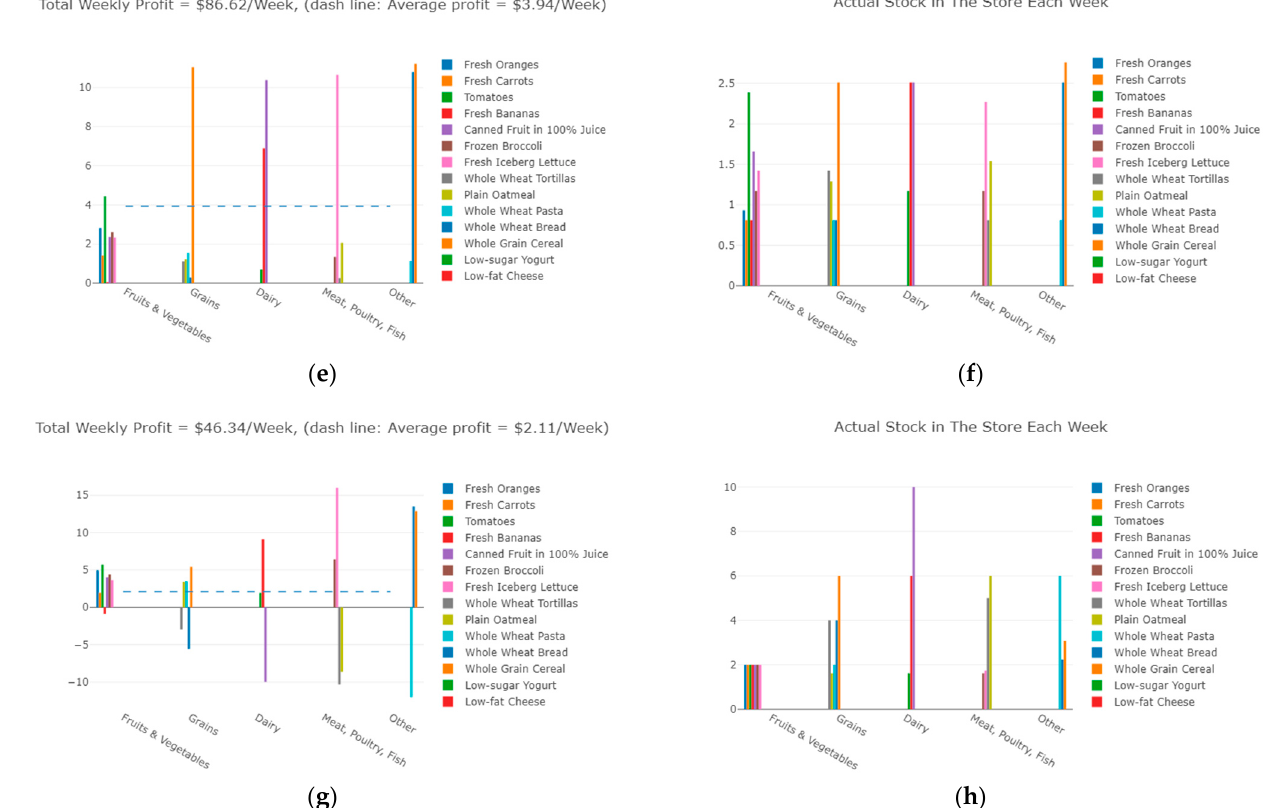
Figure 7. Simulation Results: ( a ) SNAP Minimum Weekly Profit; ( b ) SNAP Minimum Actual Stock each week; ( c ) SNAP Depth Weekly Profit; ( d ) SNAP Depth Actual Stock each week; ( e ) Minneapolis Weekly Profit; ( f ) Minneapolis Actual Stock each week; ( g ) WIC Weekly Profit; ( h ) WIC Actual Stock each week.